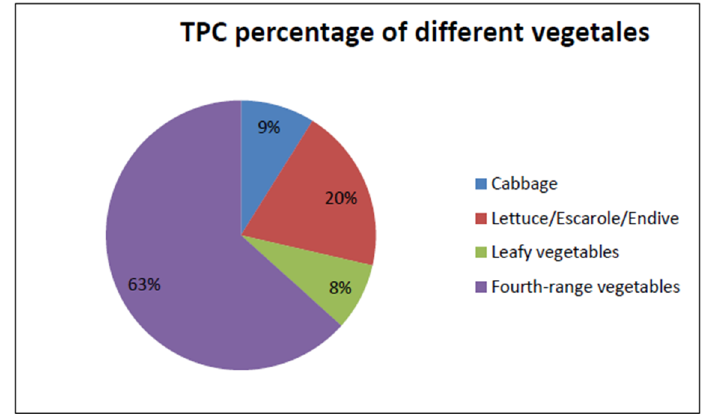
Figure 4. Percentage contribution to TEAC and TPC of the different vegetables consumed in Spain.